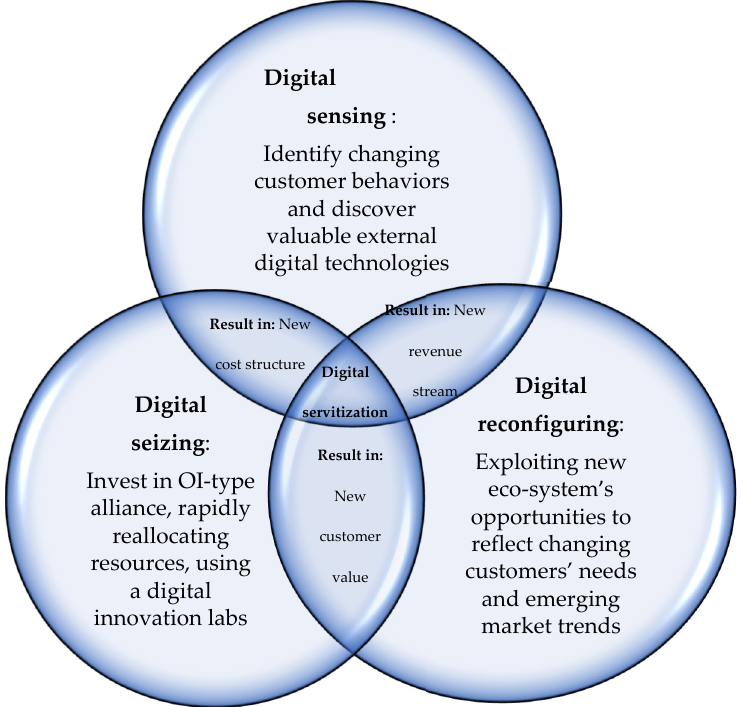
Figure 2. Integration of digital dynamic capabilities and strategic renewal of business model’s components (outcome business model) in the process of digital servitization. Source: adapted from Č irjevskis (2019) and modified.